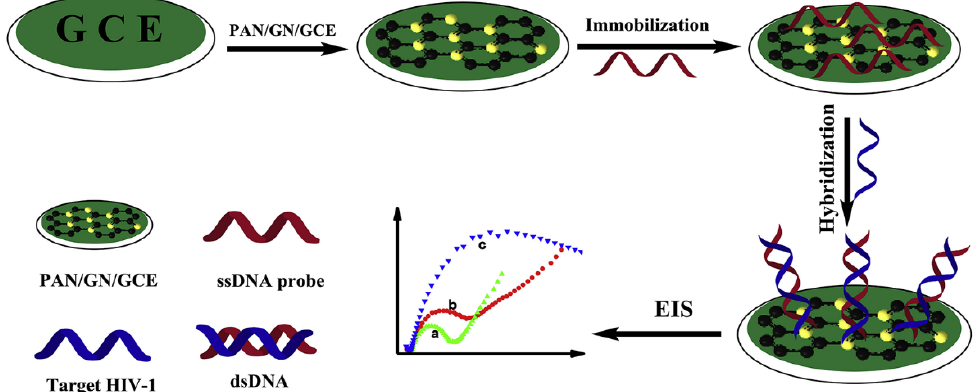
Figure 10. Schematic illustration of the fabrication of HIV-1 gene sensor based on PAN/GN/DNA nanocomposite. The inner graph shows cyclic voltammograms of (a) PAN/GN/GCE, (b) ssHIV/PAN/GN/GCE, and (c) ssHIV/PAN/GN/GCE hybridized with 1 × 10 − 11 M of target HIV. Re- produced with permission from Gong et al., J. Mater.; published by Elsevier, 2019 [20].